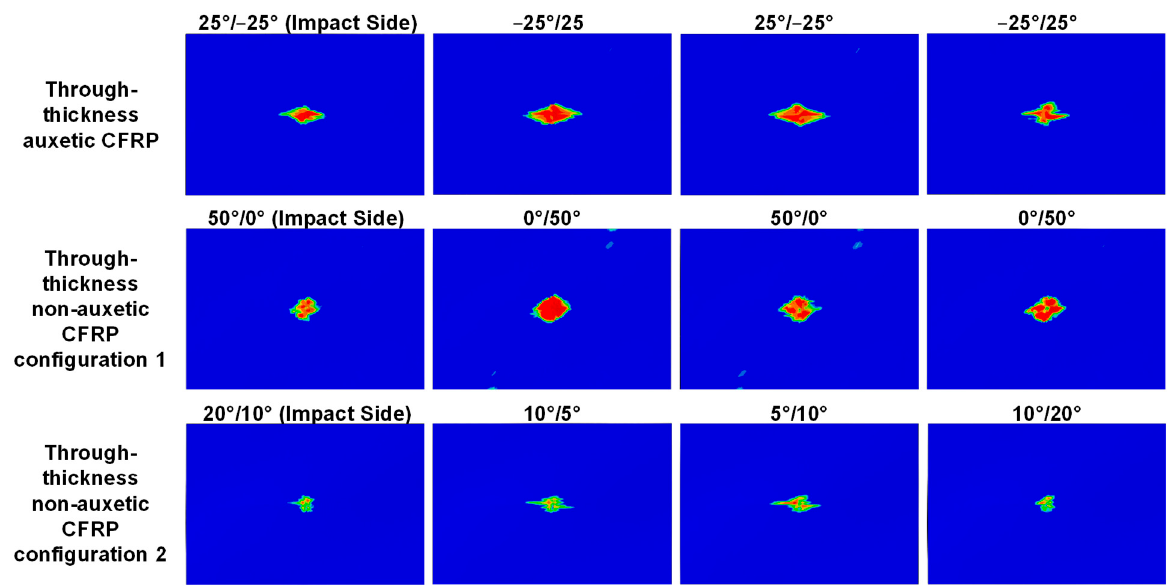
Figure 7. Effect of the through-thickness negative Poisson’s ratio on the delamination: comparison of predicted delamination pattern in each interface of auxetic CFRP composite (layup: [25 2 / − 25 2 /25 2 / − 25 2 /25 2 ], results shown in the first row) and the corresponding non-auxetic laminates in two configurations (layups: [50 2 /0 2 /50 2 /0 2 /50 2 ] and [20 2 /10 2 /5 2 /10 2 /20 2 ], results shown in the second and third rows), at an 8 J impact. The red color indicates complete delamination while the blue color indicates no delamination.